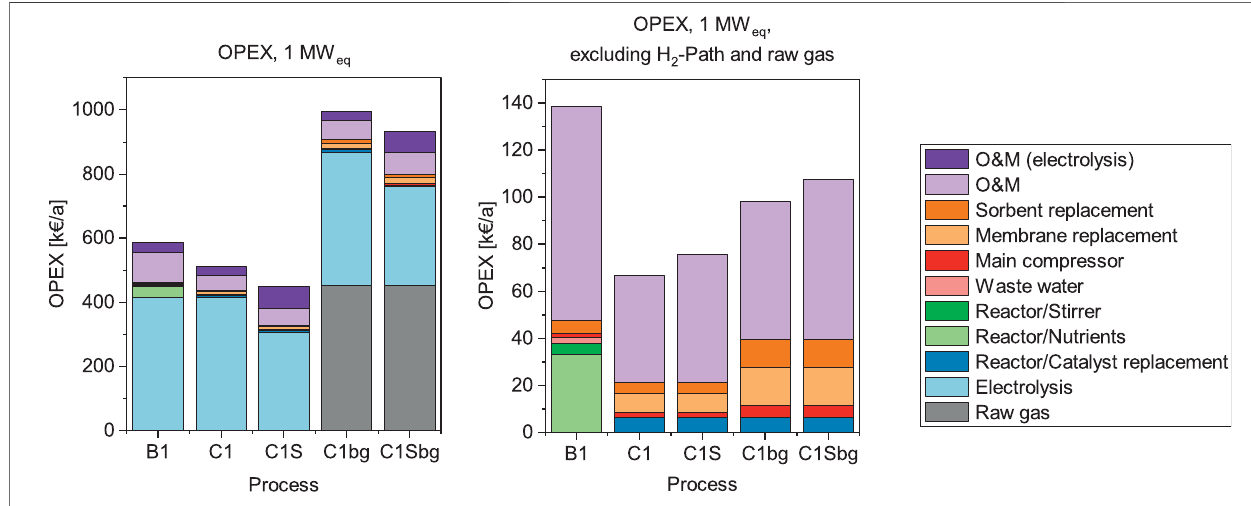
FIGURE 5 | Operation cost (OPEX) of the 1 MW el processes in k € per year. The OPEX including the H 2 -path are shown on the left, the right side shows the cost structure without the H 2 -path and the corresponding O&M